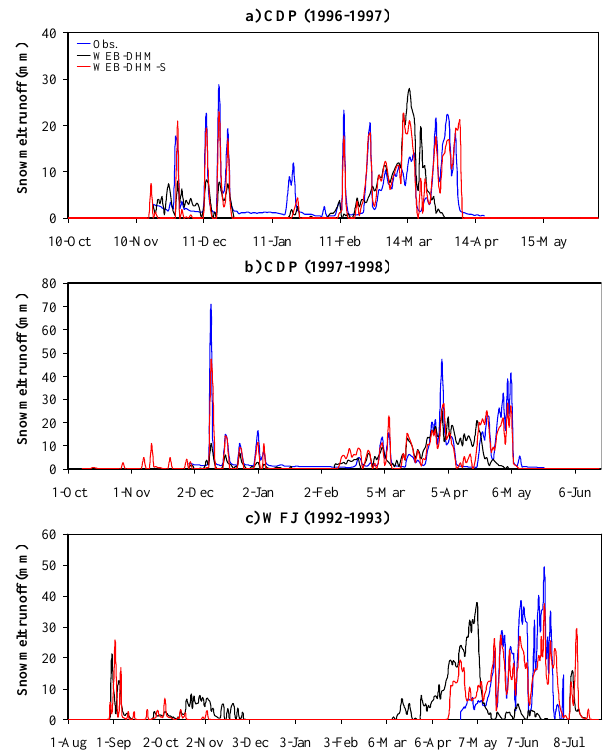
Fig. 4c. Same as in Fig. 4a at WFJ (1992–1993) from 28 Octo- ber 1992 to 3 May 1993.